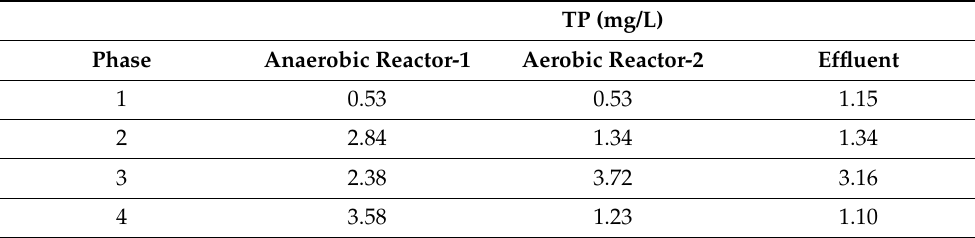
Table 4. Results of TP concentrations in the anaerobic reactor (1), the aerobic reactor (2), and the treated effluent during the